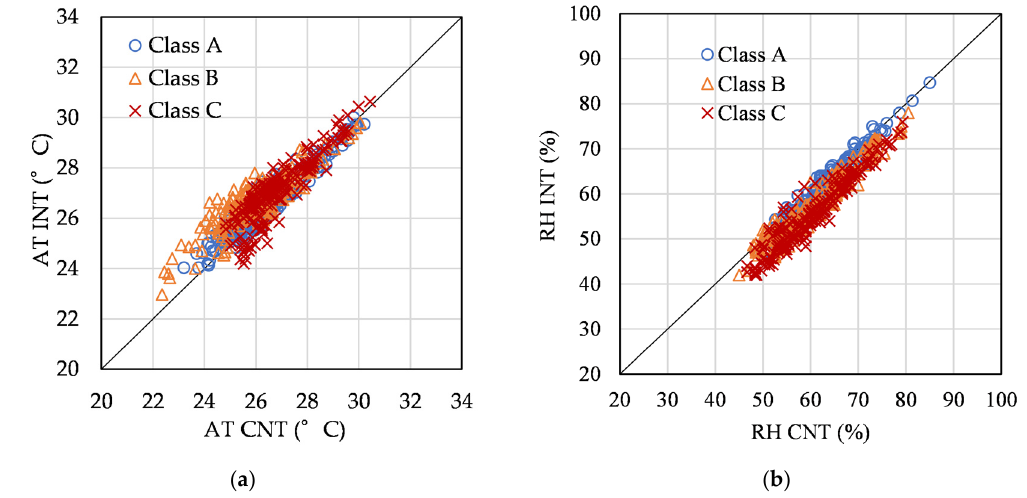
Figure 18. PER and CNT correlation for ( a ) air temperature and ( b ) relative humidity.